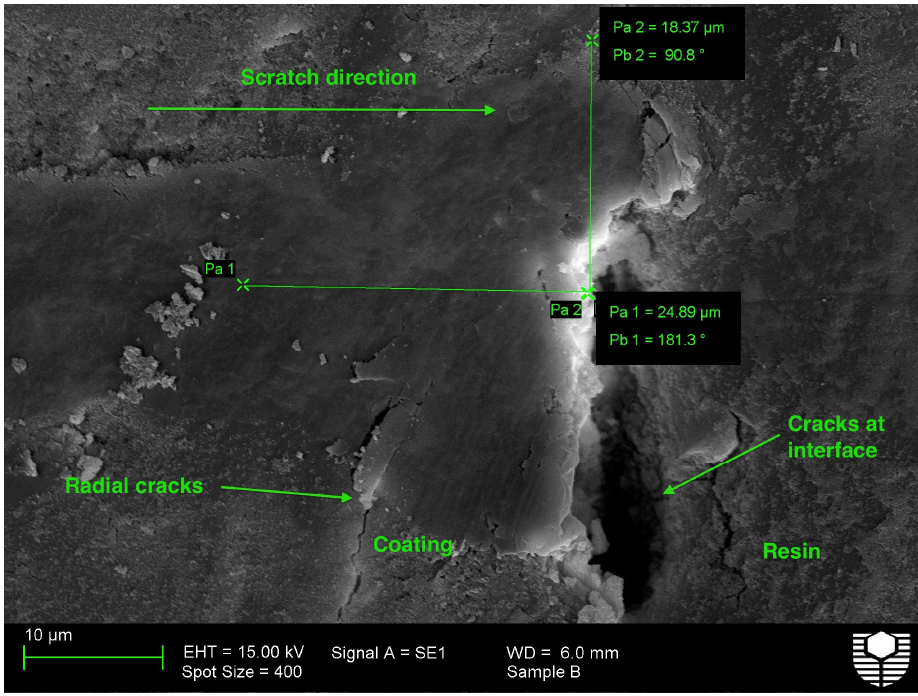
Figure 5. SEM image showing cone formation (coating thickness: 600 µ m).